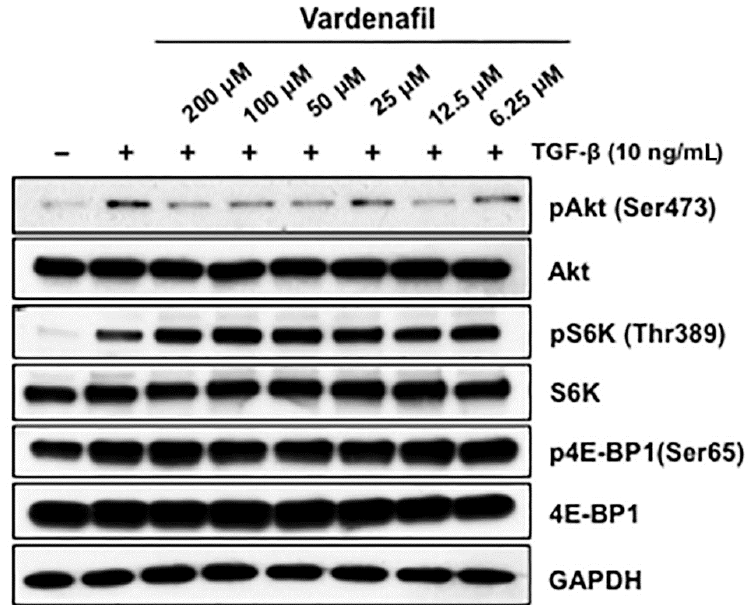
Figure 5. Vardenafil pretreatment suppressed the mTORC2 signaling pathway but not mTORC1. Fibroblasts (AKR-2B) in 0.1% FBS/DMEM were cultured with various vardenafil concentrations and were treated in the absence ( − ) or presence (+) of TGF- β (10 ng/mL). Following 6 h of stimulation, western blot analysis was performed for the indicated signaling proteins. Data are representative of three separate experiments. Vardenafil pretreatment of the fibroblasts showed stronger pharmacodynamic decreases in mTORC2 signaling, since pAkt (Ser473), which was a target of mTORC2, was decreased upon vardenafil treatment compared with mTORC1. In contrast, pS6K (Thr389) and p4E-BP1(Ser65), which were targets of mTORC1, showed no change or increase upon vardenafil treatment, suggesting that vardenafil pretreatment is sensed by the mTORC2 signaling pathway.